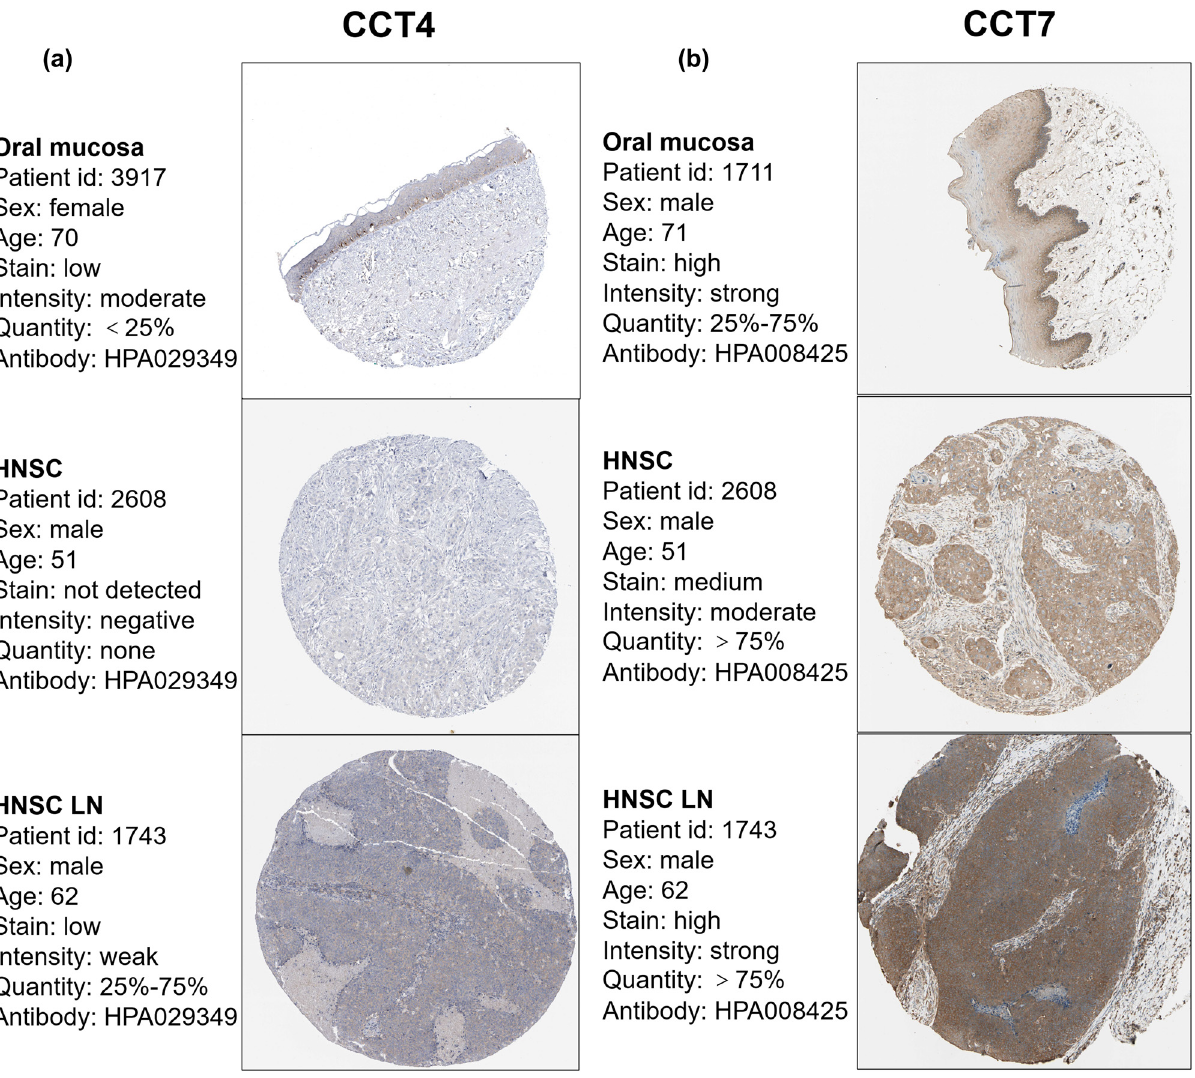
Figure 6: Validation of CCT4/7 in the translational level. IHC staining for CCTs in HNSC and normal tissue from the Human Protein Atlas Portal. ( a and b ) Validation of CCT4 and CCT7 in HNSC primary site, lymph node metastasis, and normal tissue by The Human Protein Atlas database ( IHC )